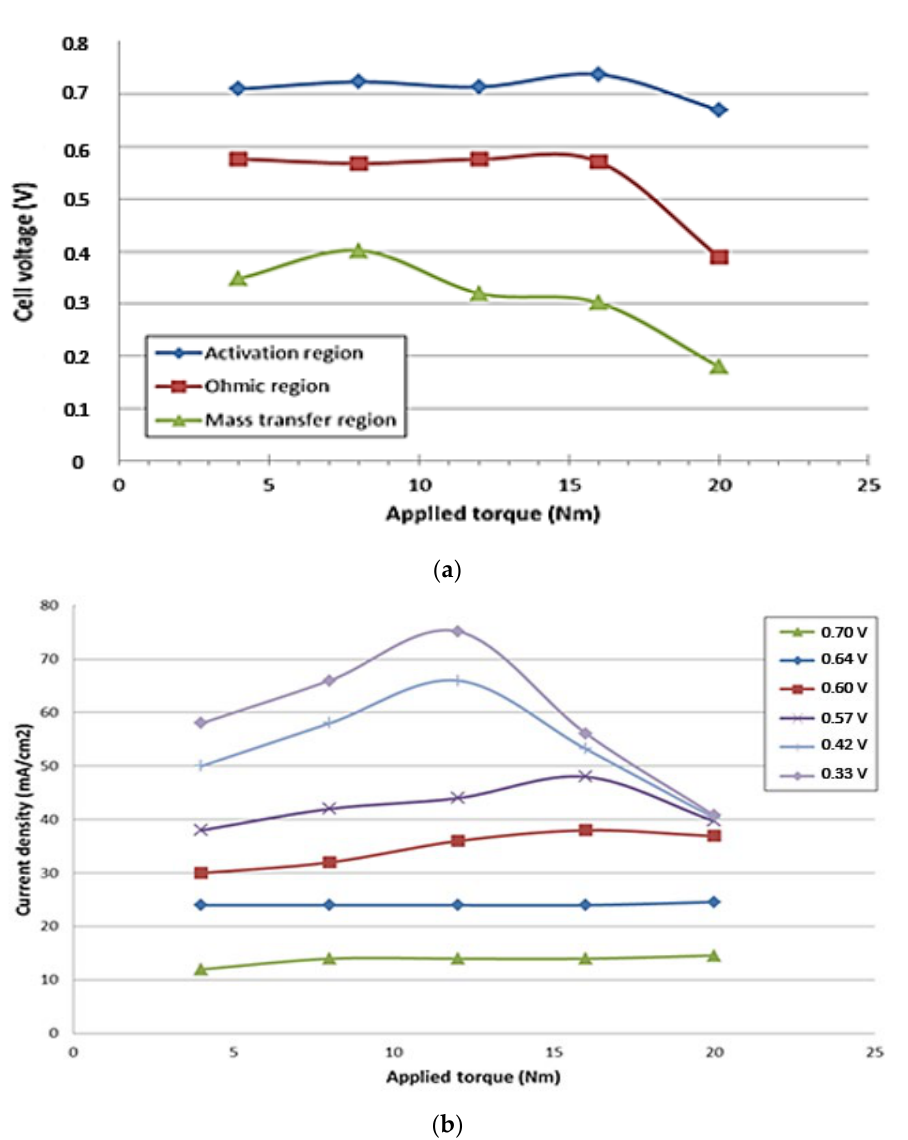
Figure 7. ( a ) Applied torque vs. cell voltages at the activation, ohmic, and mass transfer regions, ( b ) applied torque vs. current density at the different operating voltages.